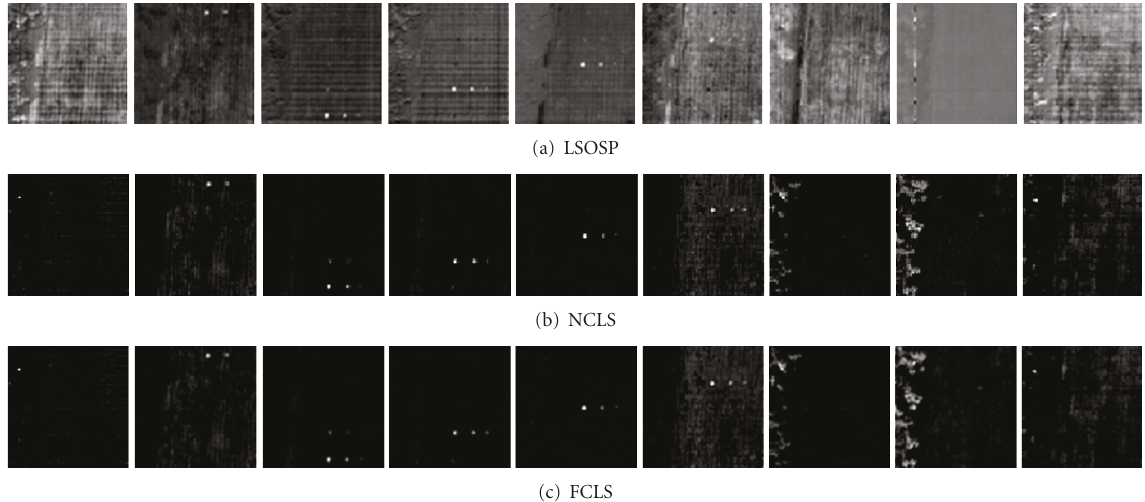
Figure 23: 9 target classes obtained by LSOSP, NCLS, and FCLS using the target pixels generated by ATGP-USTFA.